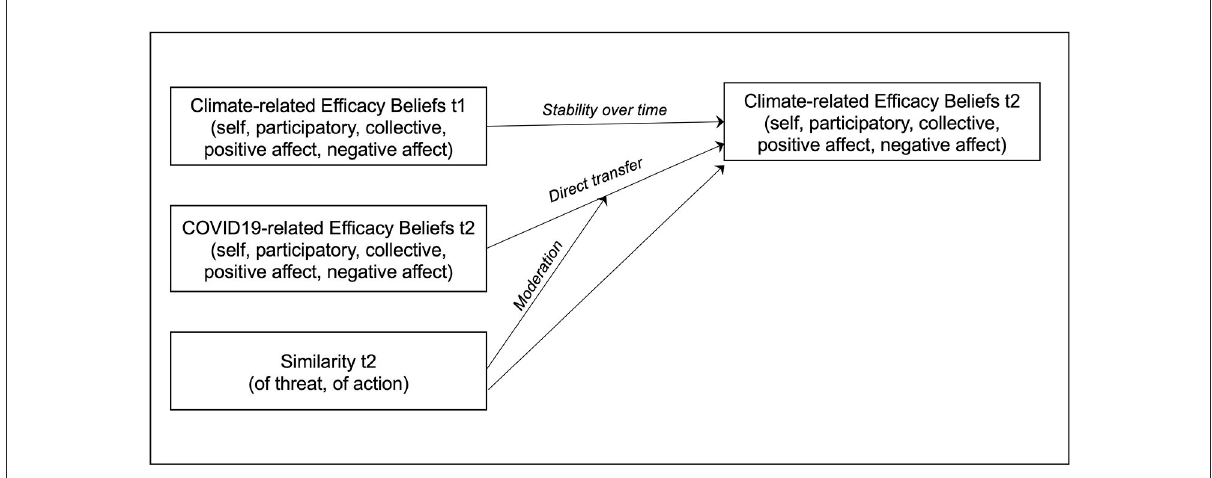
FIGURE1 Mediation model of Study 1 assuming an indirect effect of COVID-19-related efficacy beliefs on climate-friendly behavioral responses via climate-related efficacy beliefs (The labeling of the paths facilitates interpretation of the estimates in Tables 1,